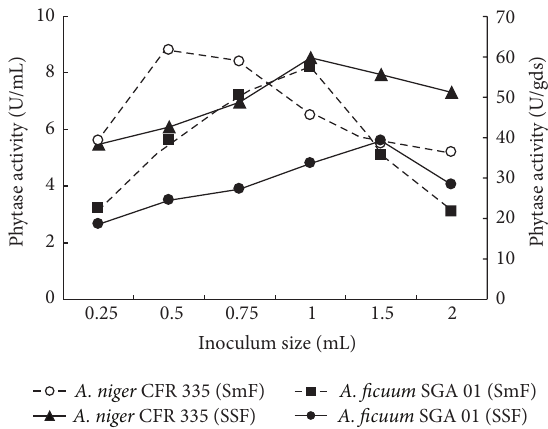
Figure 1: Effect of inoculum age on phytase production by Asper- gillus niger CFR 335 and Aspergillus ficuum SGA 01 in submerged and solid-state fermentation.